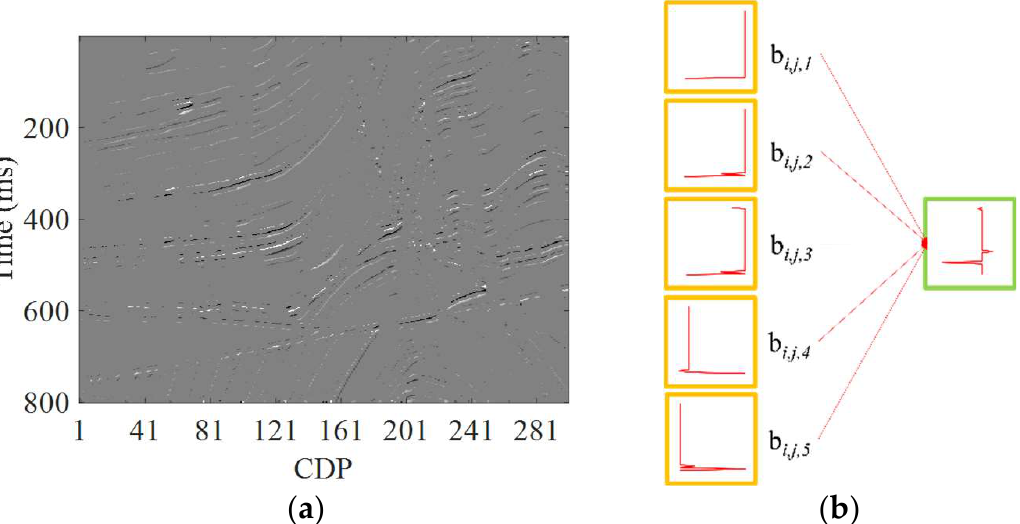
Figure 3. The schematic diagram for obtaining NLM interpolation coefficients based on feature map. ( a ) The feature map from the fourth element in sparse vector, ( b ) feature maps of borehole points (yellow rectangle) and interpolated point (green rectangle) are used to calculate the interpolation weight coefficients b i , j , q .